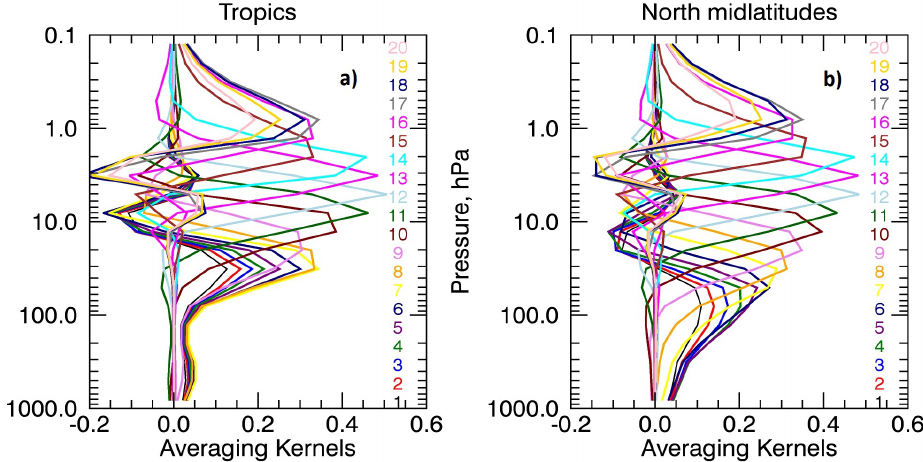
Fig. 2. Typical SBUV averaging kernels for (a) the tropics and (b) northern middle latitudes. Different colors correspond to individual layers, and layer numbers are indicated on the right.